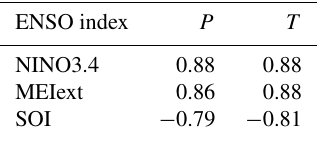
Table B1. Correlations (Pearson product-moment correlation coef- ficient R ) between ENSO indices and 20CRv2c precipitation ( P ) and temperature ( T )